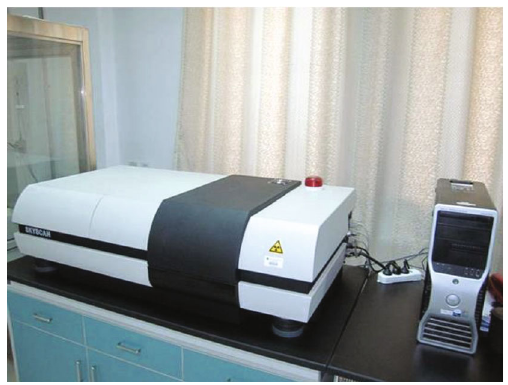
Figure 4: SkyScan 1172 high-resolution CT scanner.